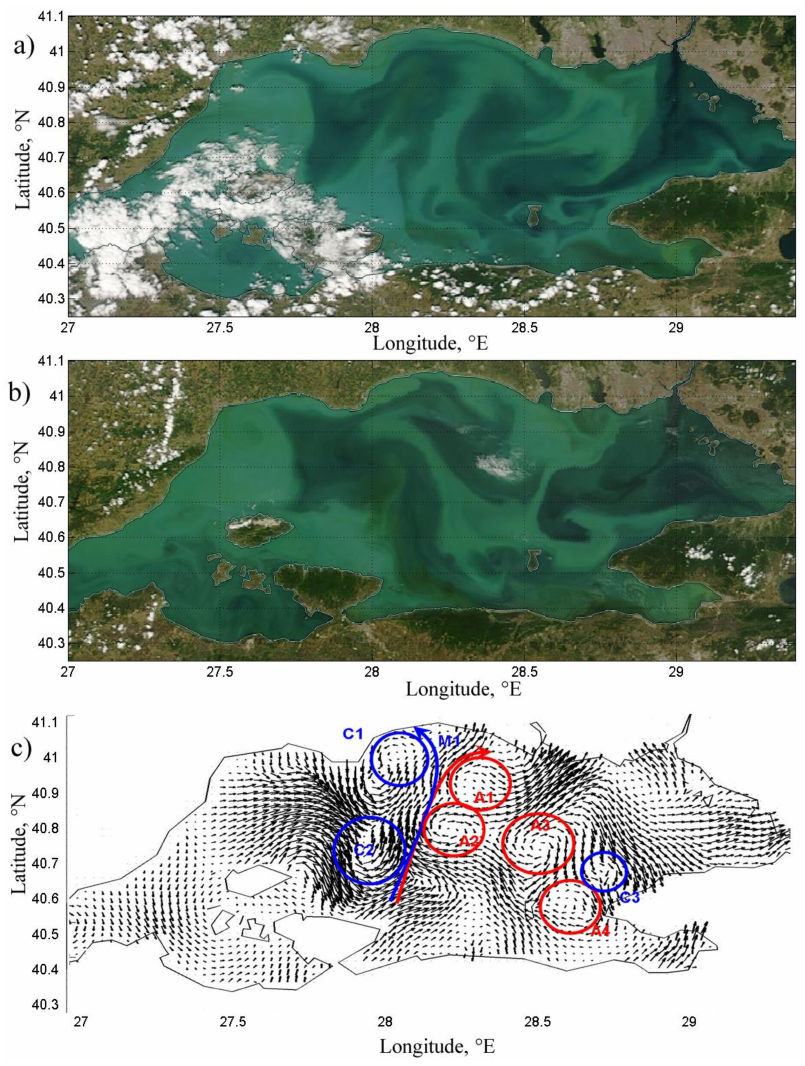
Figure 7. ( a ) MODIS-Aqua RGB composite at 25 May 2015 9:00; ( b ) MODIS-Terra RGB composite at 26 May 2015, 11:25; ( c ) current velocity calculated from optical imagery using 4D-Var. In the eastern and southern part of the sea, the currents are weakest and mainly directed to the east. The velocities obtained here are generally less than 0.04 m · s − 1 . The most intense current velocities, which reach 0.25 m · s − 1 , are observed in the northwestern part of the basin, above Marmara Island (Figure 8a). The intensification of eastward currents in this part of the basin is related to the wind forcing. At the time of measurement, the winds were eastward and had a local maximum in the northwest part of the basin with velocity up to 8 m · s − 1 (Figure 8b). The position and direction of the wind maximum coincide well with the maximum estimated current velocity. Therefore, the intensification of currents is mainly related to the wind drift currents. Wind drift currents play an important role in controlling fluxes across the Bosphorus and Dardanelles. Depending on the wind direction, they can lead to significant intensification or total blockage of the exchange across the straits [8,62,63]. Today, the relationship between wind and wind drift currents is still poorly understood, and the exact mechanisms of wind impact on the exchange in the strait are unknown. 4D-Var assimilation of satellite imagery can be used to provide new data on the relationship between atmospheric forcing and interbasin